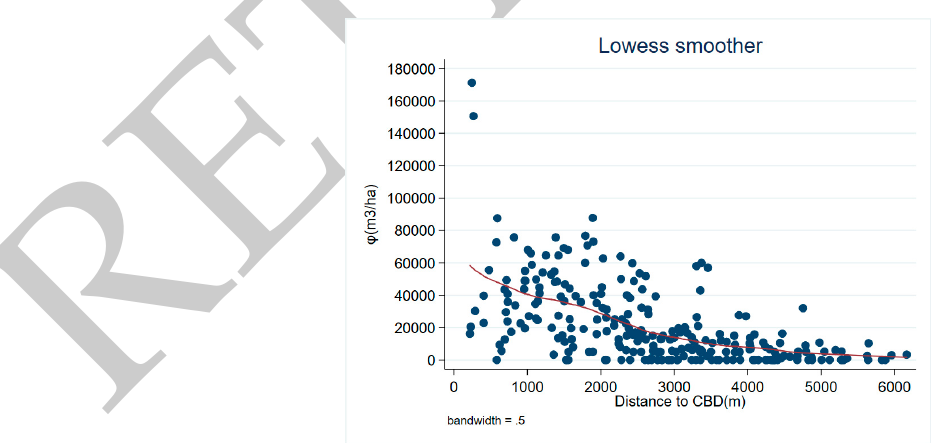
Figure 6. Relationship between cumulative metabolism and distance from the central business district (CBD). The dark dot represents the material accumulation of the sample point, and the red line is the fitting line.